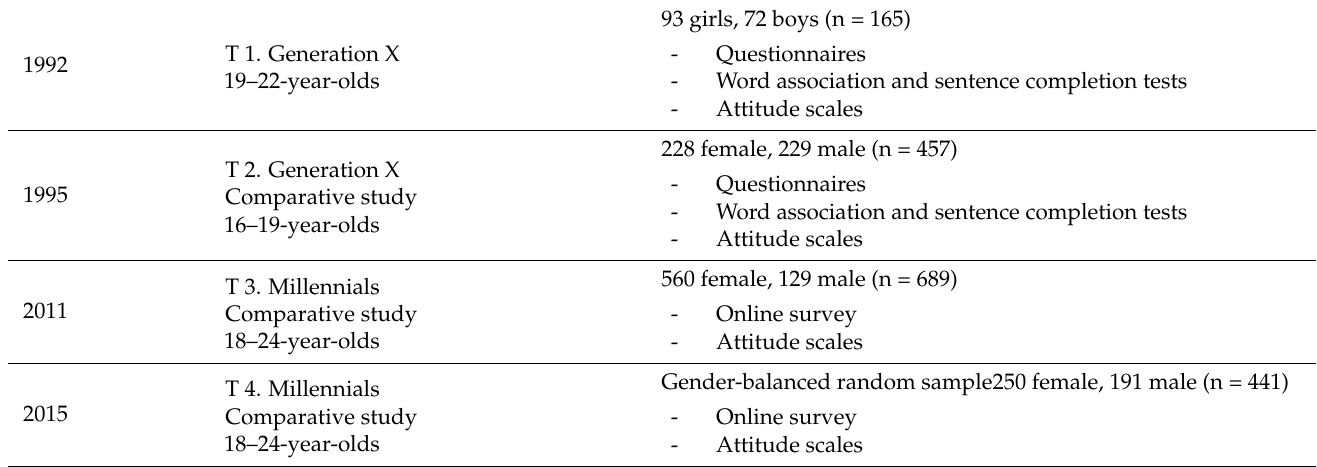
Table A1. The phases and methods of the